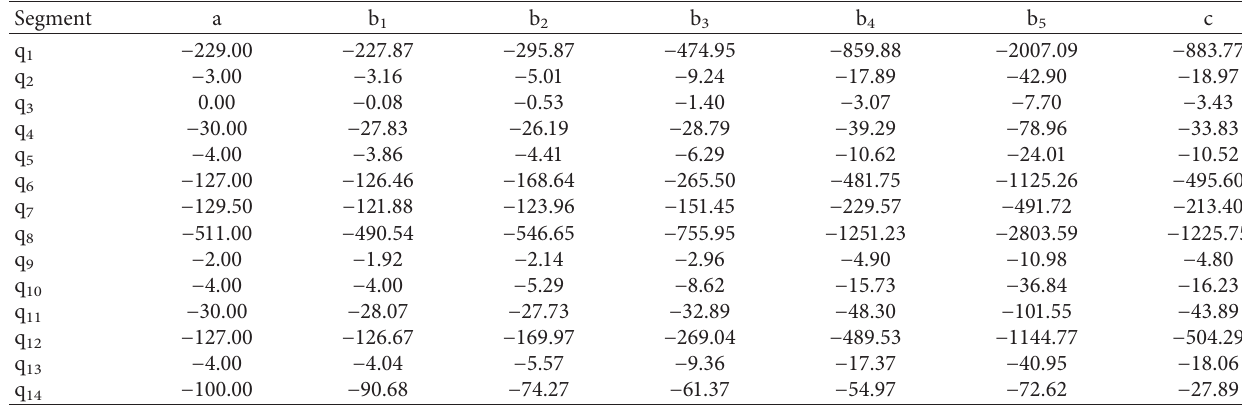
Table 7: The action-value of 14 segments in 9 trip chain.